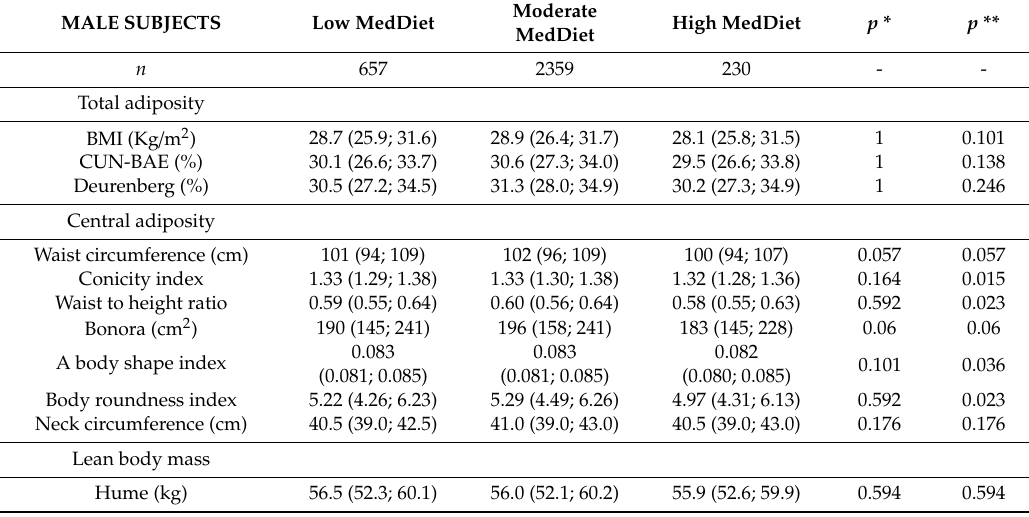
Table 4. Results of the obesity indices in male and female participants according to their adherence to the Mediterranean